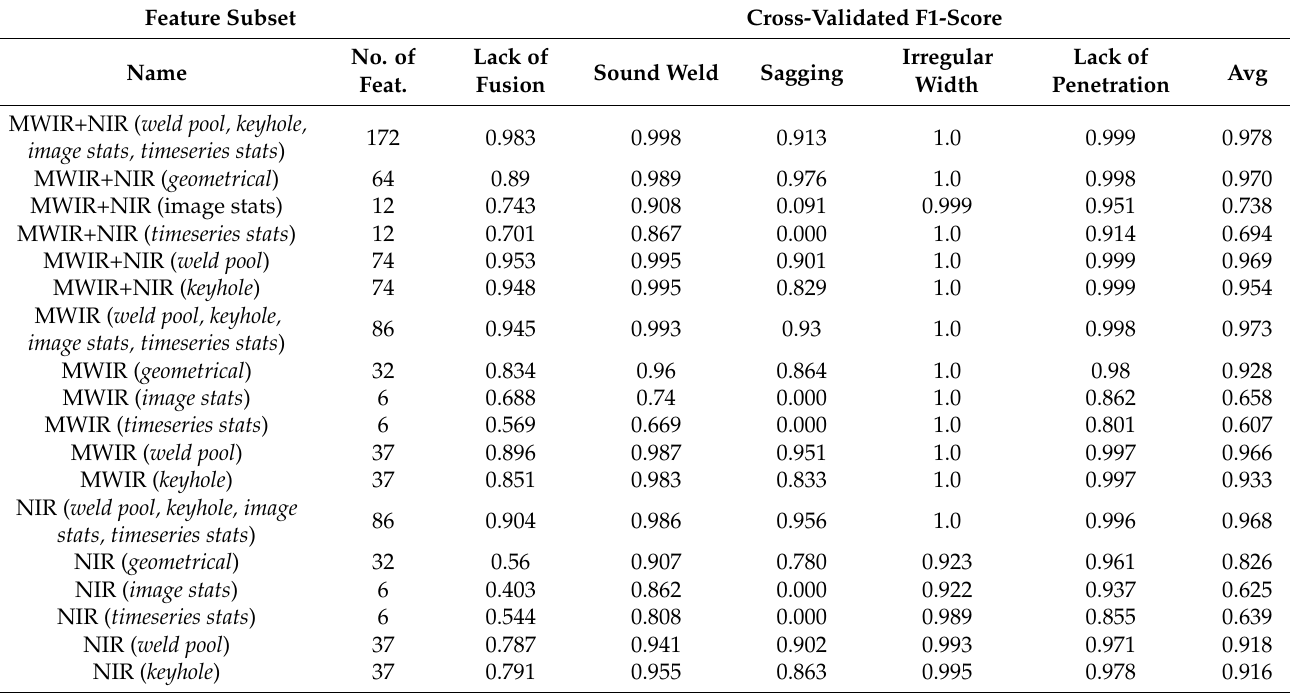
Table 3. Comparison of several feature subsets with respect to their ability to predict different weld defects (without “no weld”